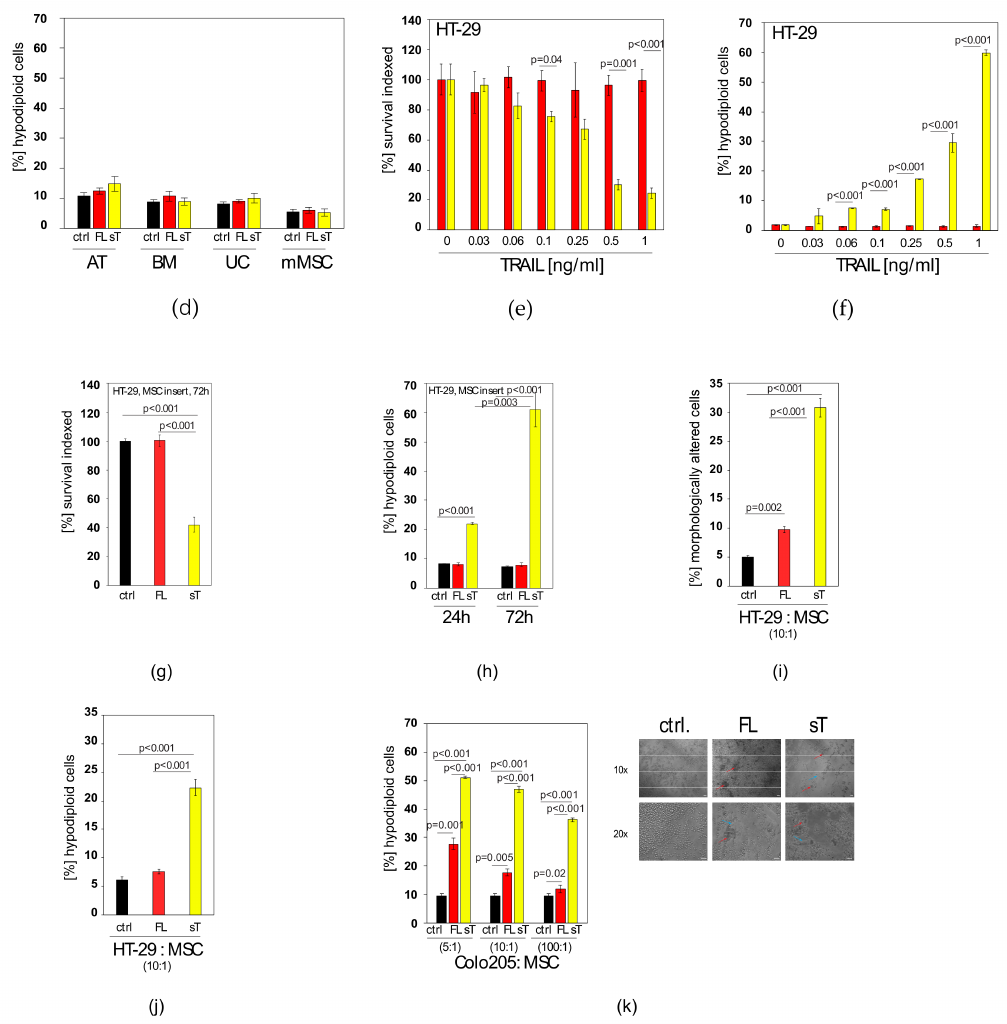
Figure 3. MSC.sTRAIL induces higher apoptosis levels in colorectal cancer cells than MSC.FL-TRAIL. ( a ) Murine MSCs (mMSCs) were transduced with a control adenoviral vector (ctrl), a vector expressing FL-TRAIL (FL) or a vector expressing sTRAIL (sT). The resulting medium supernatants were either taken as crude supernatants (c), centrifuged (s) or filtered through a 0.45 µ m filter (f) before TRAIL levels were measured by ELISA. ( b ) Human MSCs (hMSCs) were transduced with a control adenoviral vector (ctrl), a vector expressing FL-TRAIL (FL) or a vector expressing sTRAIL (sT). The resulting medium supernatants were either taken as crude supernatants (c), centrifuged (s) or filtered through a 0.45 µ m filter (f) before TRAIL levels were measured by ELISA. ( c ) Di ff erent types of MSCs (adipose tissue-derived - AT, bone marrow-derived - BM, and umbilical cord-derived - UC) were transduced with a control adenoviral vector (ctrl), a vector expressing FL-TRAIL (FL) or a vector expressing sTRAIL (sT). The resulting medium supernatants were passed through a 0.45 µ m filter before TRAIL levels were measured by ELISA. ( d ) Apoptosis was measured in di ff erent types of MSCs, adipose tissue-derived (AT), bone marrow-derived (BM) and umbilical cord-derived (UC) and mouse (mMSC) MSCs that were transduced with a control adenoviral vector (ctrl), a vector expressing FL-TRAIL (FL) or a vector expressing sTRAIL (sT). ( e ) Survival was measured in HT-29 cells after exposure to supernatants from MSC.FL-TRAIL (red) and MSC.sTRAIL (yellow) at increasing concentrations of sTRAIL. For MSC.FL-TRAIL supernatants equal volumes of supernatant were used for each corresponding sTRAIL concentration. ( f ) Apoptosis was measured in HT-29 cells after exposure to supernatants from MSC.FL-TRAIL (red) and MSC.sTRAIL (yellow) at increasing concentrations of sTRAIL. For MSC.FL-TRAIL supernatants equal volumes of supernatant were used for each corresponding sTRAIL concentration. ( g ) Survival was measured in HT-29 cells that were co-cultured with control MSCs (ctrl), MSC.FL-TRAIL (FL) or MSC.sTRAIL (sT)